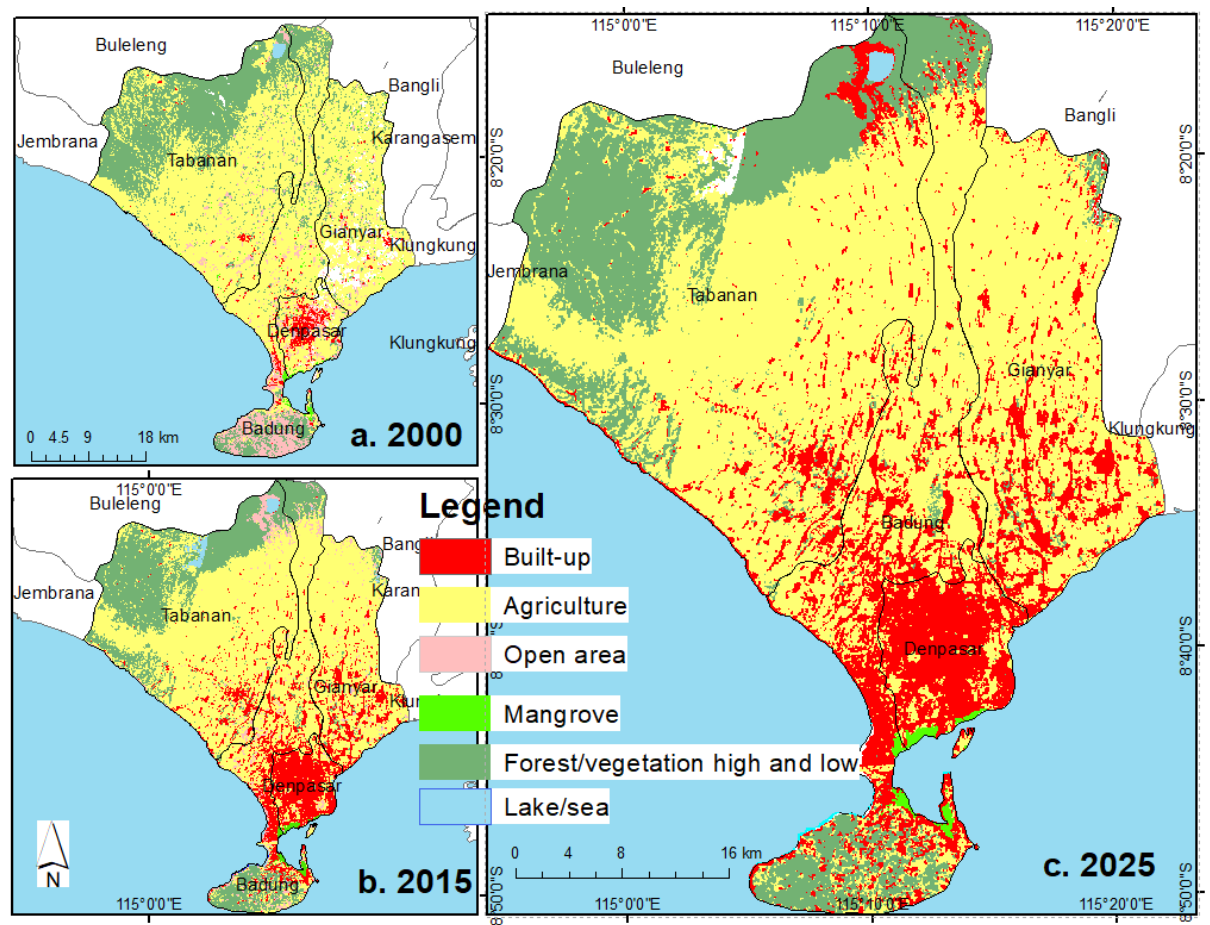
Figure 4. a. LULC in 2015, b. LULC in 2015, and c. LULC Prediction for